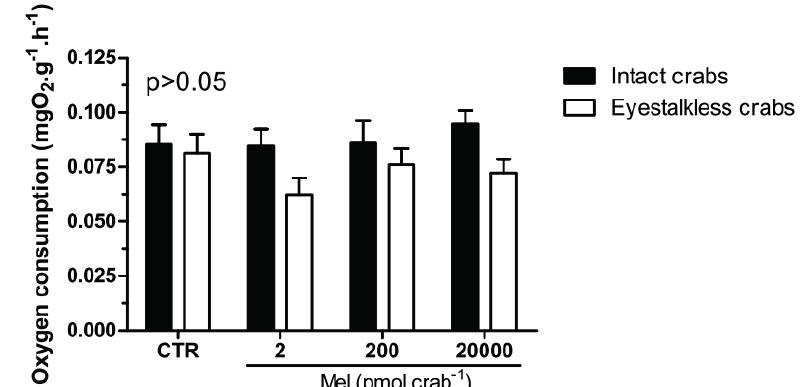
Figure 6. Oxygen consumption (VO 2 ) of intact (black bars) and eyestalkless (open bars) Neohelice granulata exposed for 45 min only to 6 mgO 2 ·L − 1 and injected with physiological saline (CTR) or melatonin (2, 200 or 20,000 pmol·crab − 1 ). Each point represents the mean ± SE ( n = 3–6). No significant differences ( p > 0.05) were